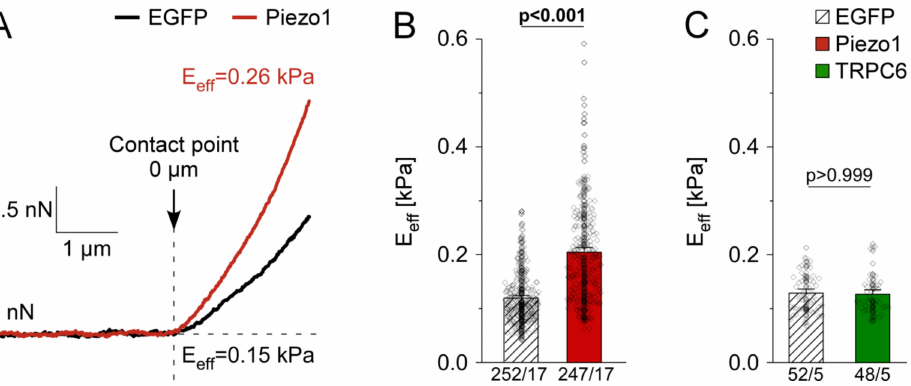
Figure 2. Piezo1 overexpression induces stiffening of human embryonic kidney cell (HEK) cells. ( A ) representative force vs. indentation curves from cells overexpressing EGFP or Piezo1 acquired by nanoindentation. Average stiffness of cells overexpressing EGFP or Piezo1 ( B ) or transient receptor potential channel 6 (TRPC6) ( C ) 3 days post-transfection. n/N = number of cells/ number of